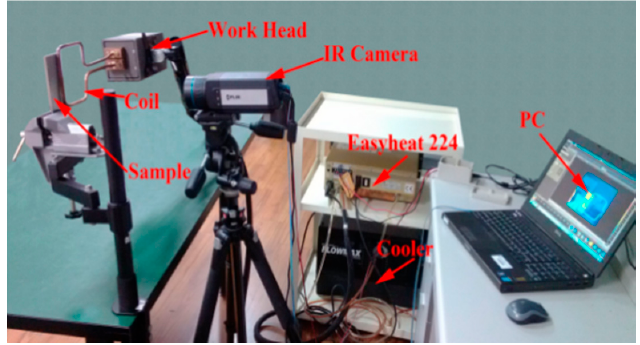
Figure 4. Experiment setup.